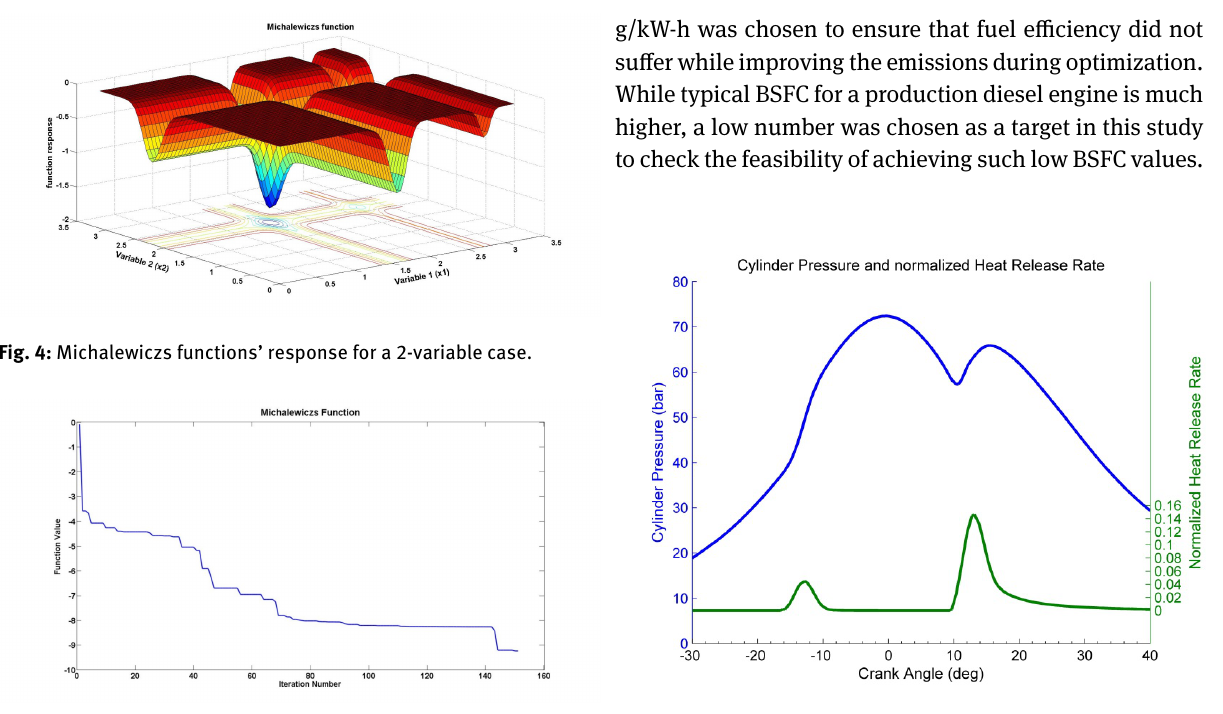
Fig. 6: An example of cylinder pressure and burn duration for a run with pilot injection.